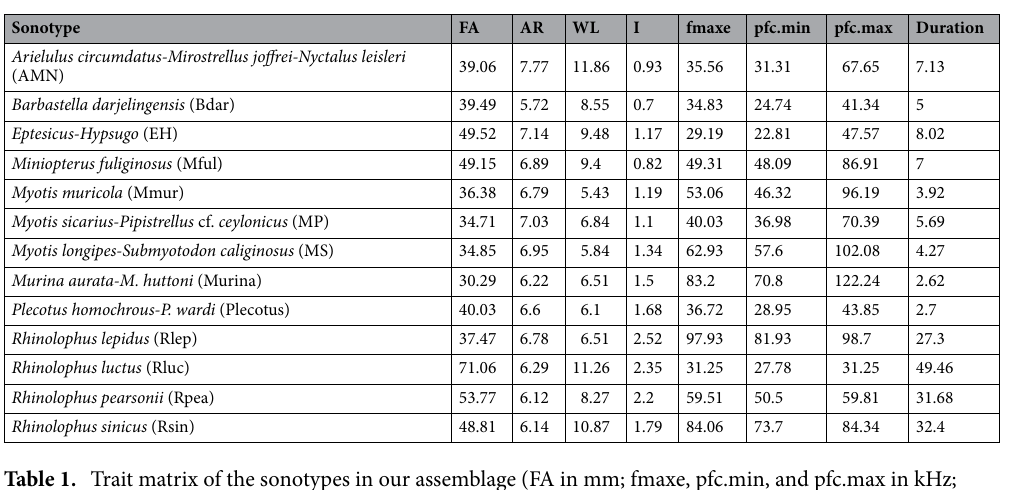
Table 1. Trait matrix of the sonotypes in our assemblage (FA in mm; fmaxe, pfc.min, and pfc.max in kHz; Duration in ms). Species means of all traits were used to run a PCA and the first four PCs were used to calculated FD